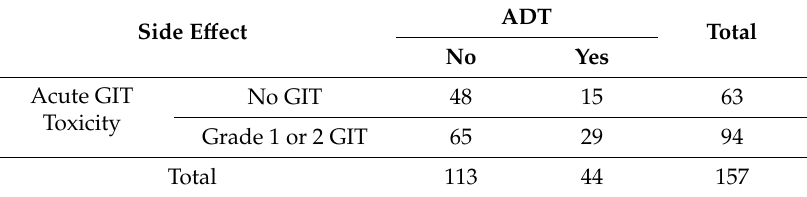
Figure 1. Kaplan–Meier estimates for ( a ) overall survival following RT with ADT ( n = 65) or without ADT ( n = 138), ( b ) the overall biochemical relapse of intermediate risk vs high risk PCa patients, and ( c ) the biochemical relapse in intermediate and high risk PCa patients following RT, with or without ADT. A multivariable Cox proportional hazards model did not show any statistically significant di ff erences between the biochemical relapse of patients treated with ADT plus RT and those treated with RT alone. Table 2. Gastrointestinal toxicity (GIT).